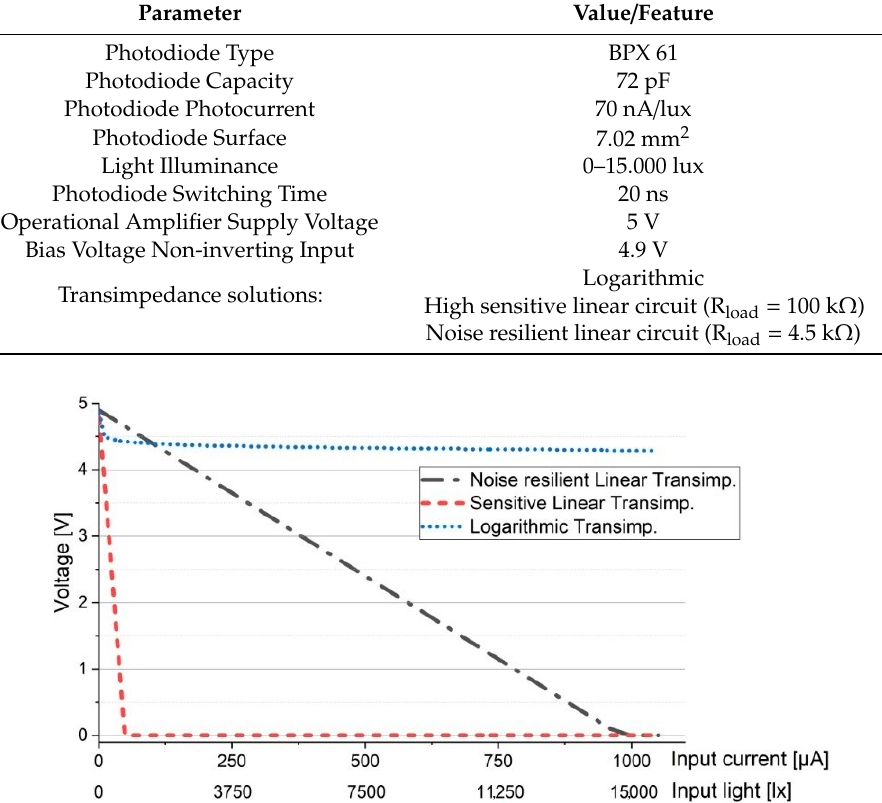
Figure 2. Evaluation of the logarithmic transimpedance circuit and its comparison to the noise resilient linear circuit and to high sensibility linear circuit. The simulation results show that a high sensitive linear transimpedance circuit is rapidly saturating whereas the logarithmic and the noise resilient linear Sensors 2019 , 19 , x FOR PEER REVIEW 13 of 23 prevent the photodiode saturation.